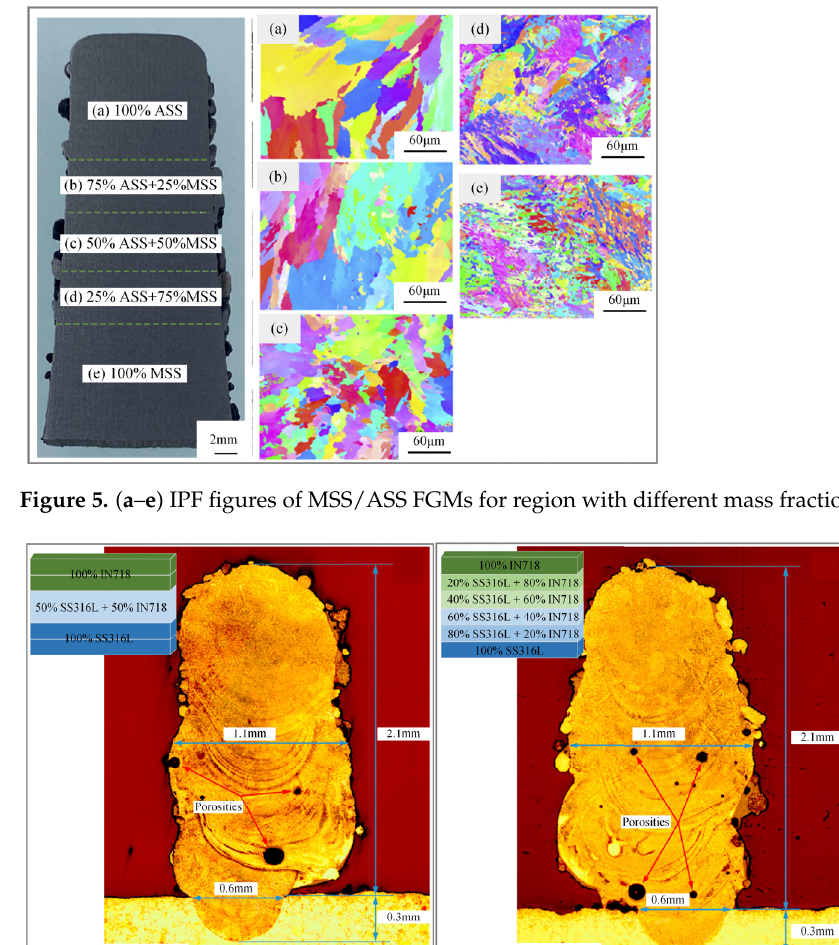
Figure 4. ( a ) Photographic image of the LENS TM process, ( b ) Schematic of the FGMs Inconel 718/SS 316L, ( c ) EBSD micrographs of the FGM in the defective compositional range of 30 wt% Inconel